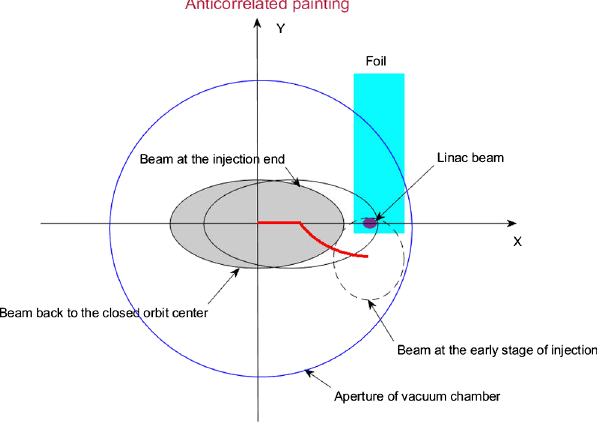
FIG. 2. Schematic drawing of the position variation of the circulating beam emittance ellipse in the anticorrelated painting